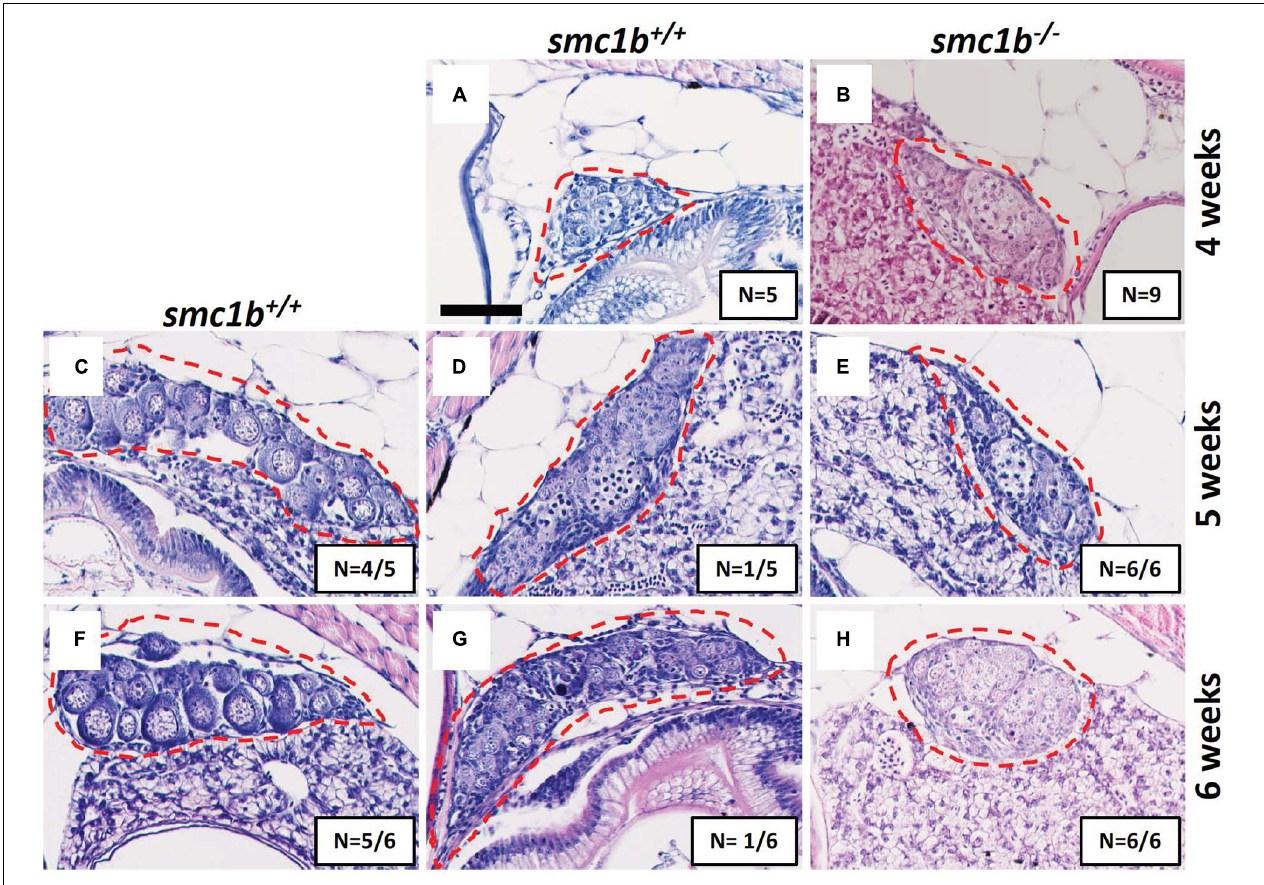
FIGURE 3 | Absence of oogenesis in smc1b Q198X mutants. Hematoxylin-eosin stain of wild-type and smc1b mutant gonads during sex-differentiation. (A,B) Undifferentiated gonads in wild-type (A) and mutant (B) fish at 4 weeks old. (C–H) Although oogenesis (C,F) and spermatogenesis (D,G) took place in wild-type gonads at 5- and 6-weeks old, only spermatogenesis progressed in the mutants (E,H) . Gonads are outlined by red dashed line, scale is 50 µ m. N = total number of individuals with the gonad histology pictured per total number of fish analyzed for each age group.